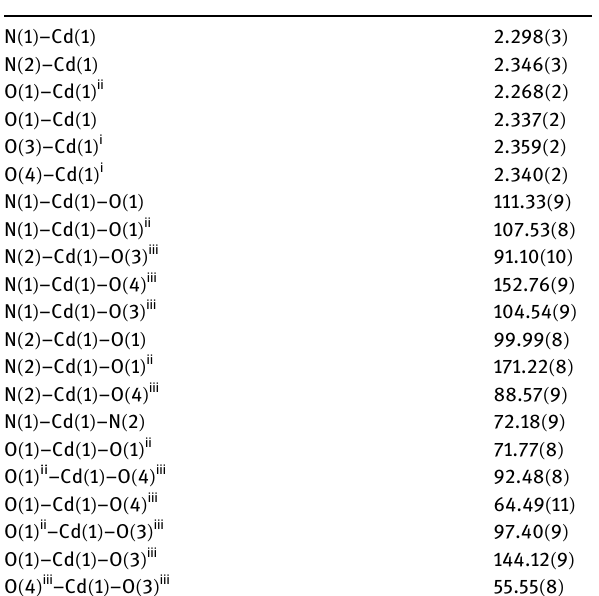
Table 1: Selected bond lengths ( Å ) and angles ( ° ) for the complex 1